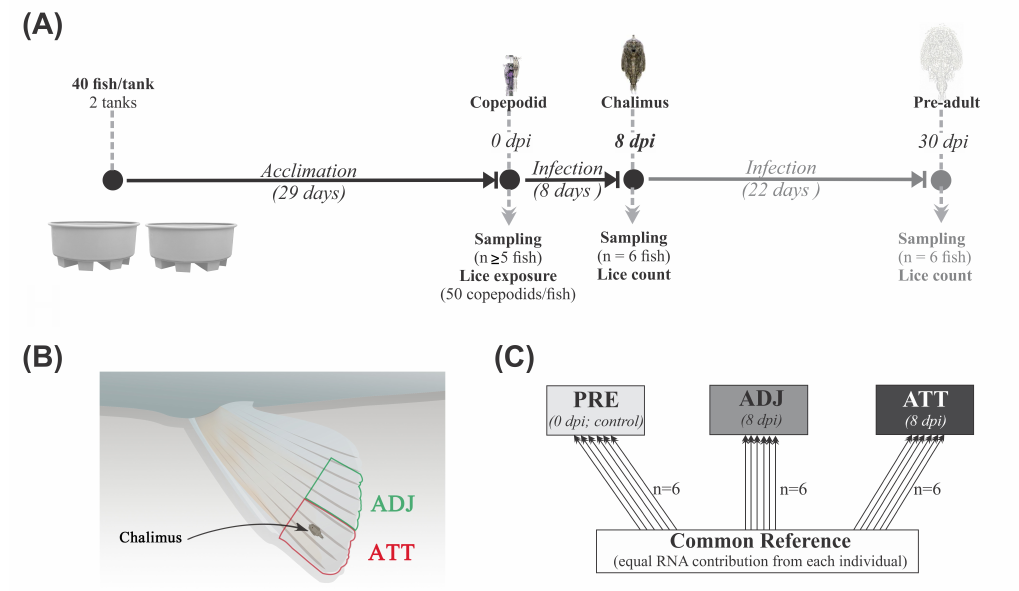
Figure 12. Overview of infection trial, sampling, and microarray design. ( A ) The design of the sea lice infection experiment. Sampling points and corresponding developmental stages of lice are indicated along the timeline (dpi, days post-infection). ( B ) Schematic sketch of fin sampling (not drawn to scale). Pelvic fin tips were sampled from chalimus-attachment (ATT) and adjacent (ADJ) sites. ( C ) Common reference-based microarray experimental design. Arrows represent the biological replicates used from three treatment groups (PRE, fins from control fish prior to lice exposure ( n = 6); ATT and ADJ, fins from chalimus-attachment and adjacent sites, respectively, both sampled from same fish ( n = 6)). The base and arrowhead show the Cy3-labelled reference pool and Cy5-labelled experimental samples,